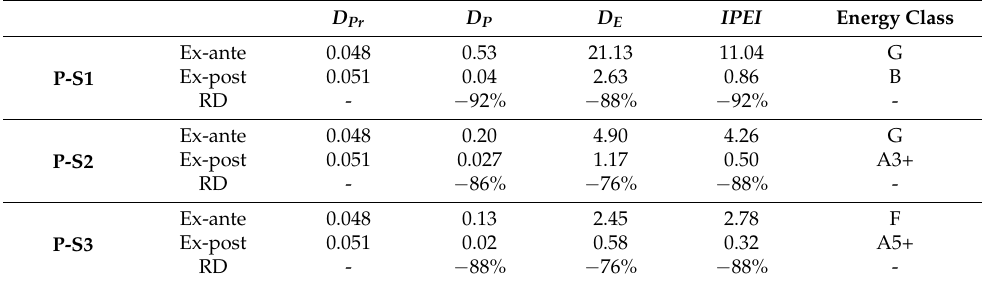
Table 13. Energy performance indicators for ex-ante and ex-post installations of pedestrian areas.